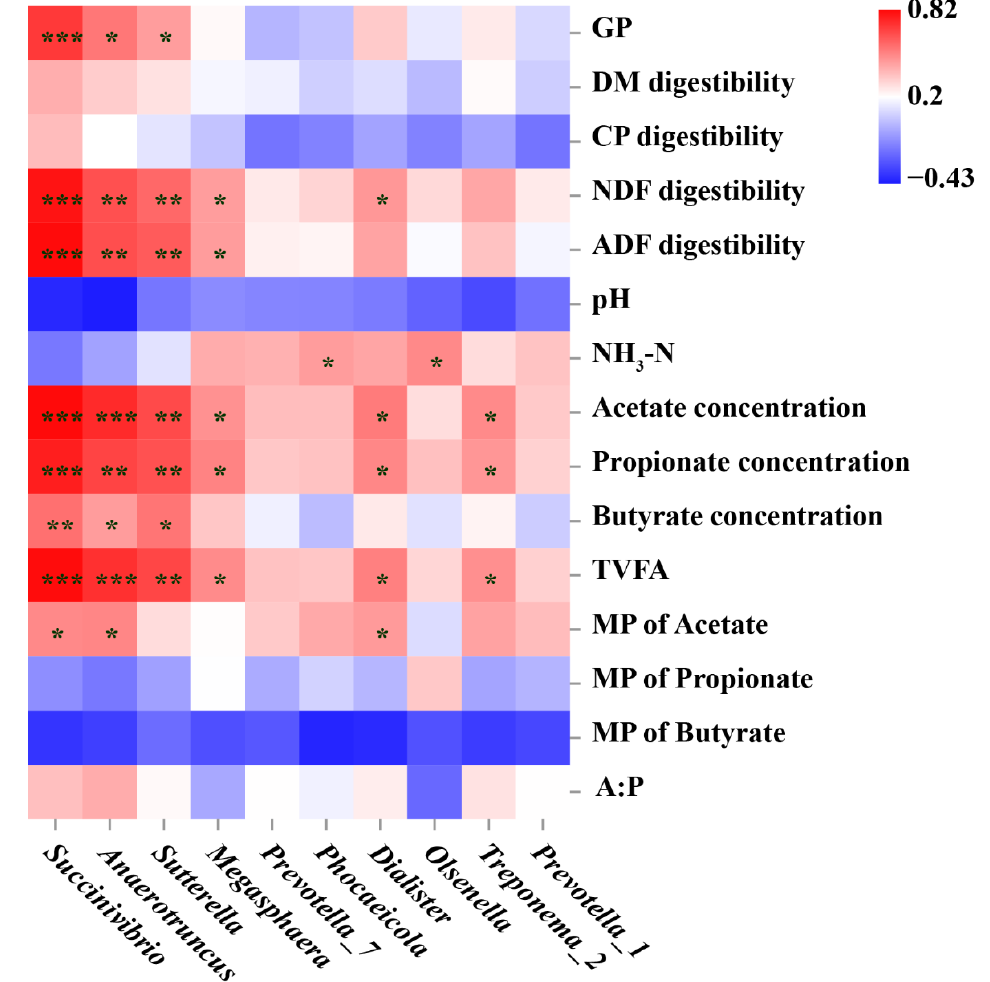
Figure 8. Spearman’s correlation between the relative abundance of genera and phenotypic indices. Genus were obtained using linear discriminant analysis effect size and found to be enriched in UR, Met, and MD groups. CON = no additive, UR = urea addition, Met = methionine addition, and MD = methionine dipeptide addition. Colors represent the correlation coefficient. Red represents a pos- itive correlation, and blue represents a negative correlation. A dark color represents a stronger cor- relation, whereas a light color represents a weaker correlation. *, 0.01 < p < 0.05; **, 0.001 < p < 0.01; ***, p ≤ 0.001; GP, gas production; DM, dry matter; CP, crude protein; NDF, neutral detergent fiber; ADF, acid detergent fiber; TVFA, total volatile fatty acid; MP, molar proportion; A:P, acetate con- centration: propionate concentration.